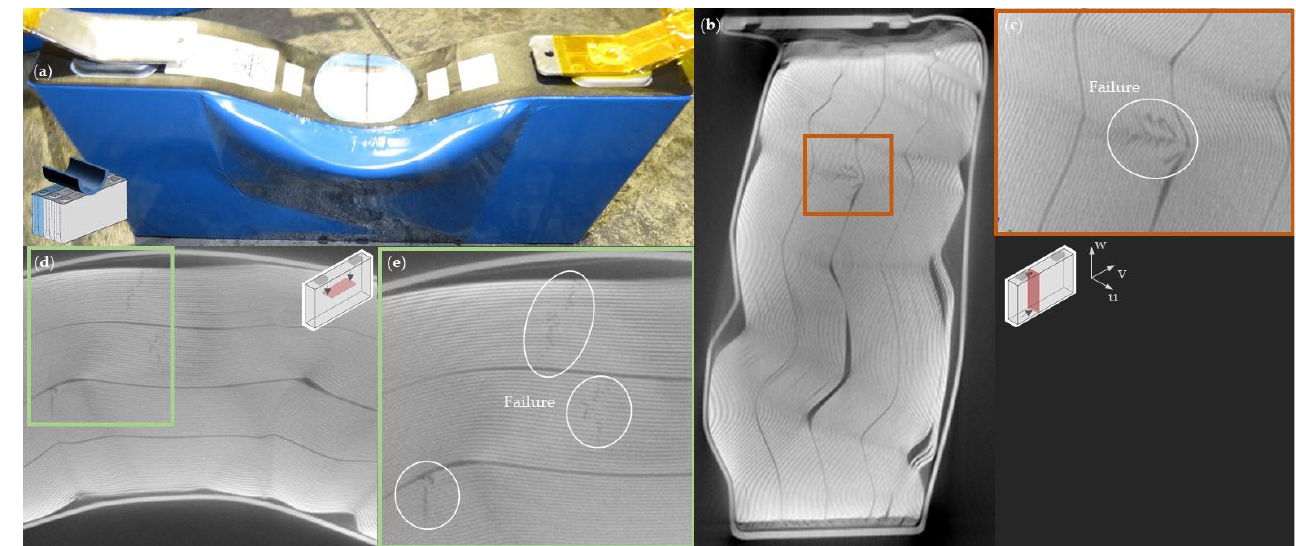
Figure 19. W-direction with cylindrical impactor: ( a ) deformed left cell; ( b – e ) CT-Scans.